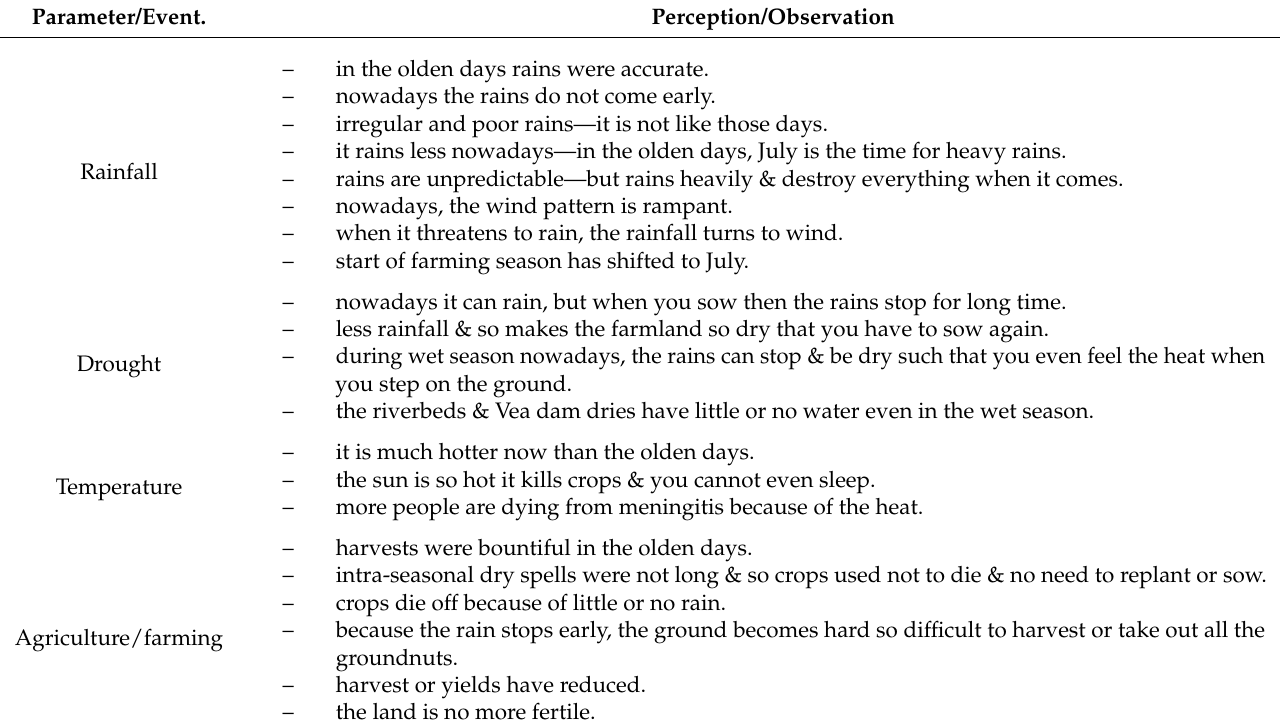
Table 2. Views of Farmers on Climate/Environmental Change and Risks.